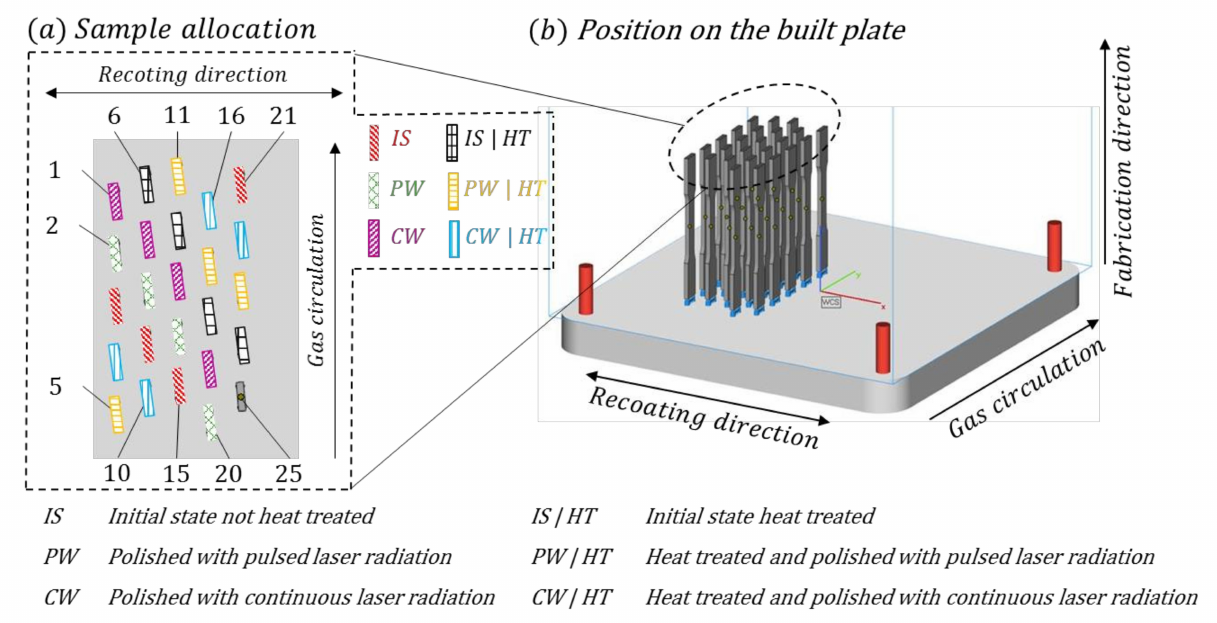
Figure 3. Positioning and orientation of the tensile specimens on the built plate, Sample allocation to different post-processing states. ( a ) Sample allocation. ( b ) Position on the built